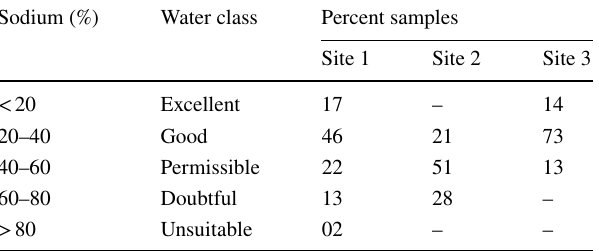
Table 12 Irrigation water quality of groundwater based on sodium percentage in study area